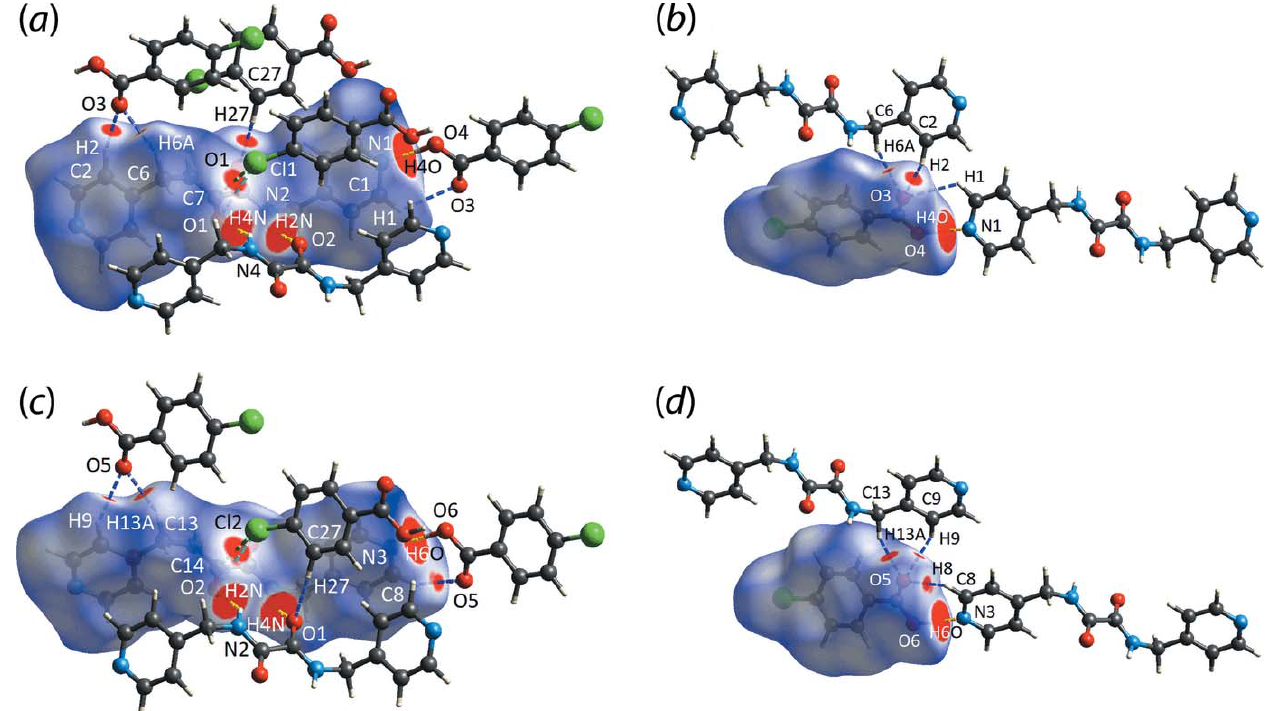
Figure 4 The d norm maps showing N—H (cid:2)(cid:2)(cid:2) O (yellow dashed lines), C—H (cid:2)(cid:2)(cid:2) O (blue), Cl (cid:2)(cid:2)(cid:2) C (green) and Cl (cid:2)(cid:2)(cid:2) O (light-blue) close contacts as indicated by the corresponding red spots with varying intensities within the range of (cid:4) 0.0503 to 1.1157 arbitrary units for ( a ) 4 L H 2 -I, ( b ) CBA-I, ( c ) 4 L H 2 -II and ( d ) CBA- II.